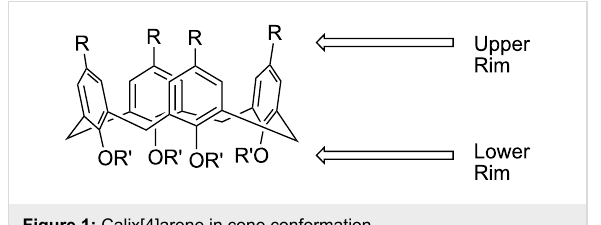
Figure 1: Calix[4]arene in cone conformation.